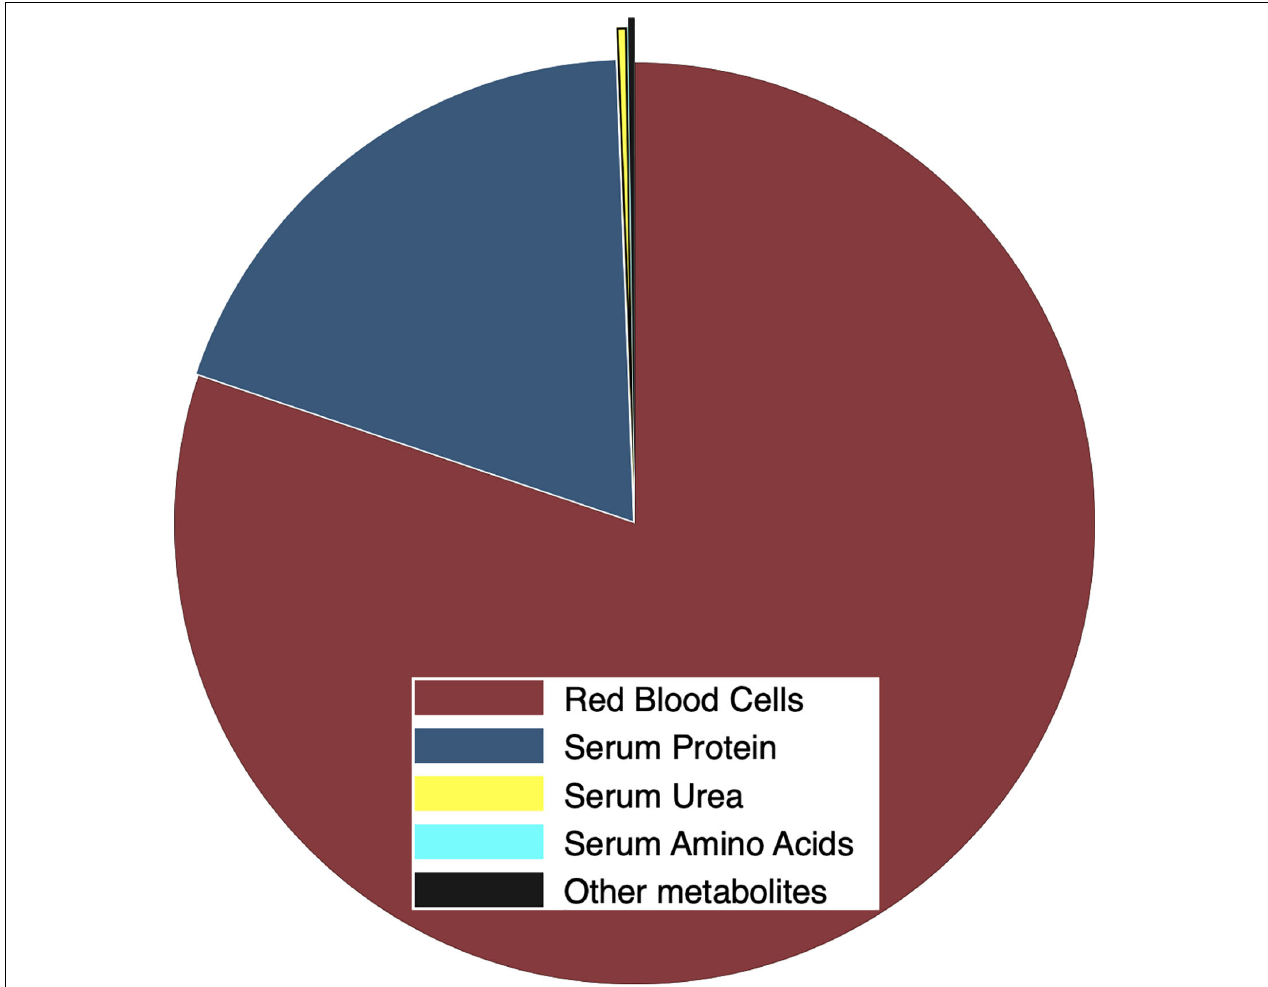
FIGURE 4 | Proportional distribution of total N (g · g − 1 ) in whole blood from female reindeer during March 2009 in Fairbanks, AK, United States. Nitrogen was allocated to red cells (maroon), plasma protein (navy), free amino acids (cyan), and urea (yellow). Creatinine and other metabolites (black) were estimated as the residual N in blood